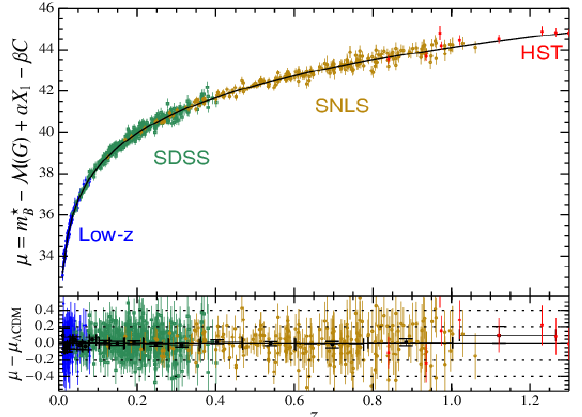
Figure 14. Joint Light-curve Analysis data (JLA). Vertical axis is the standardized distance modulus µ (luminosity distance function), and the horizontal axis is the redshift z . Source: Reference